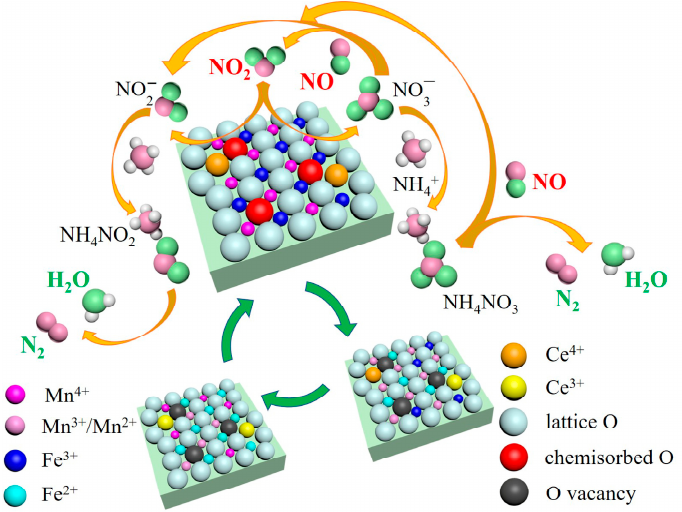
Figure 10. The possible redox catalytic pathway of the fast SCR reaction over Mn − Fe − Ce − O x / γ ‐ Al 2 O 3 nanocatalysts.